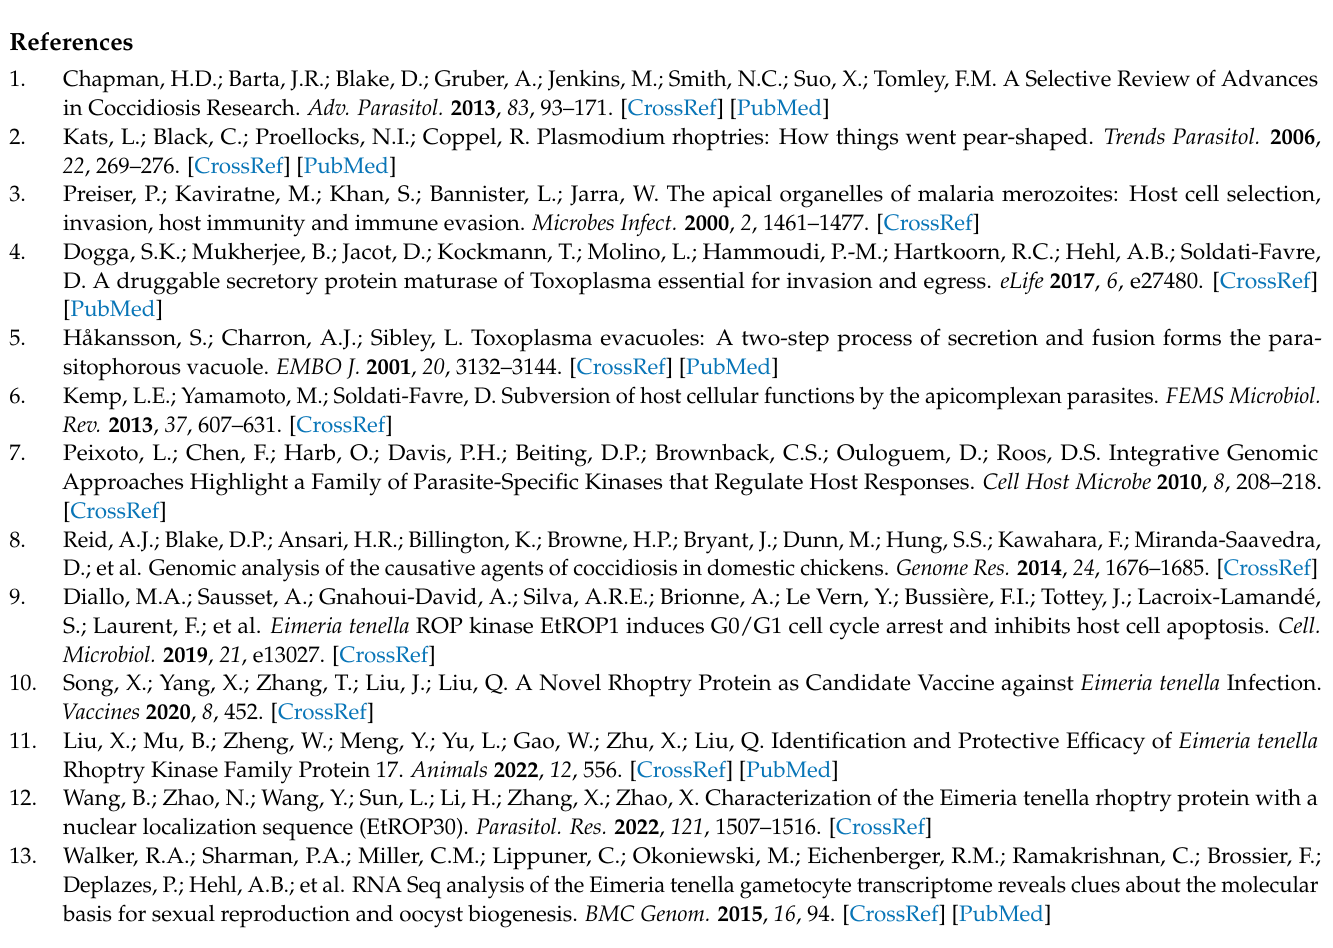
blot; Figure S3: The recombinant EtROP35 recognized by chicken serum from the challenged control group and unchallenged control